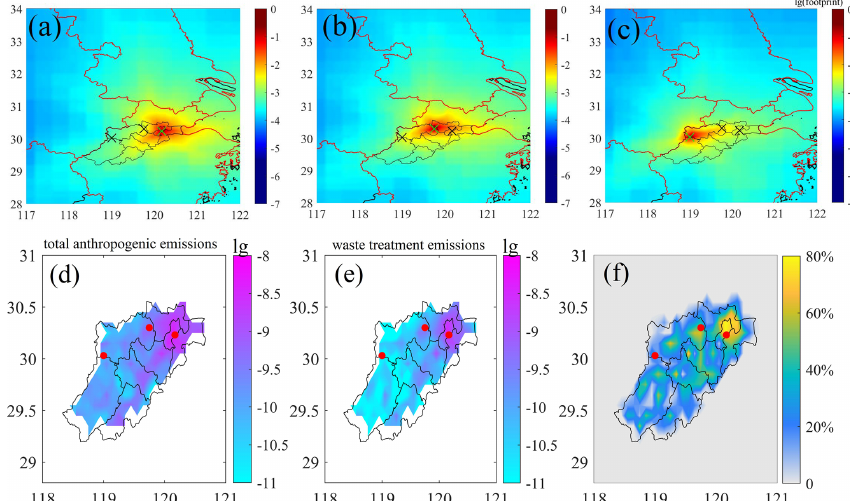
Figure 3. Annual averages of the simulated footprint for the (a) Hangzhou site, (b) Linan site and (c) Damingshan site, where the green symbol “ × ” indicates the receptor location in each panel; (d) total anthropogenic CH 4 emissions in the EDGAR v6.0 inventory; (e) waste treatment CH 4 emissions in the EDGAR v6.0 inventory; (f) waste treatment as a proportion of total anthropogenic CH 4 emissions, where red dots represent the three sites. Units for the footprint: ppmm 2 smol − 1 ; units for emissions: kgm − 2 s − 1 . The divisions in Hangzhou are different